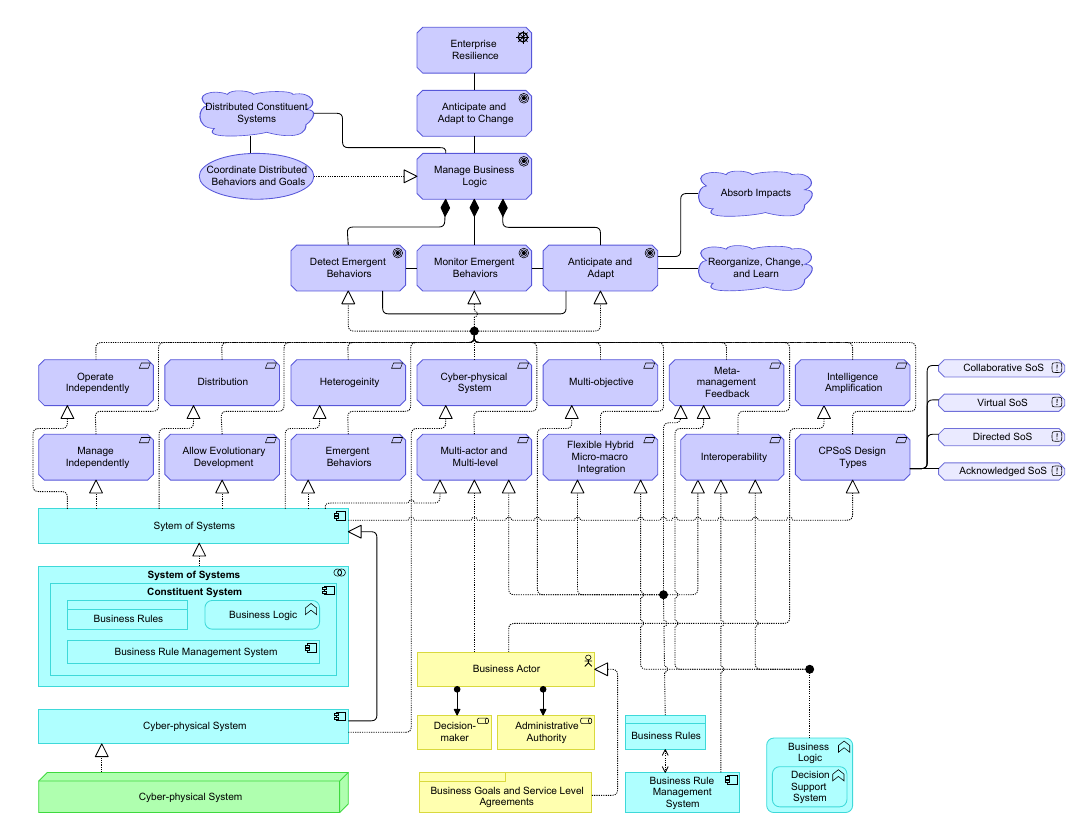
Figure 5. Motivation model linking the design goals and requirements to the corresponding architectural building